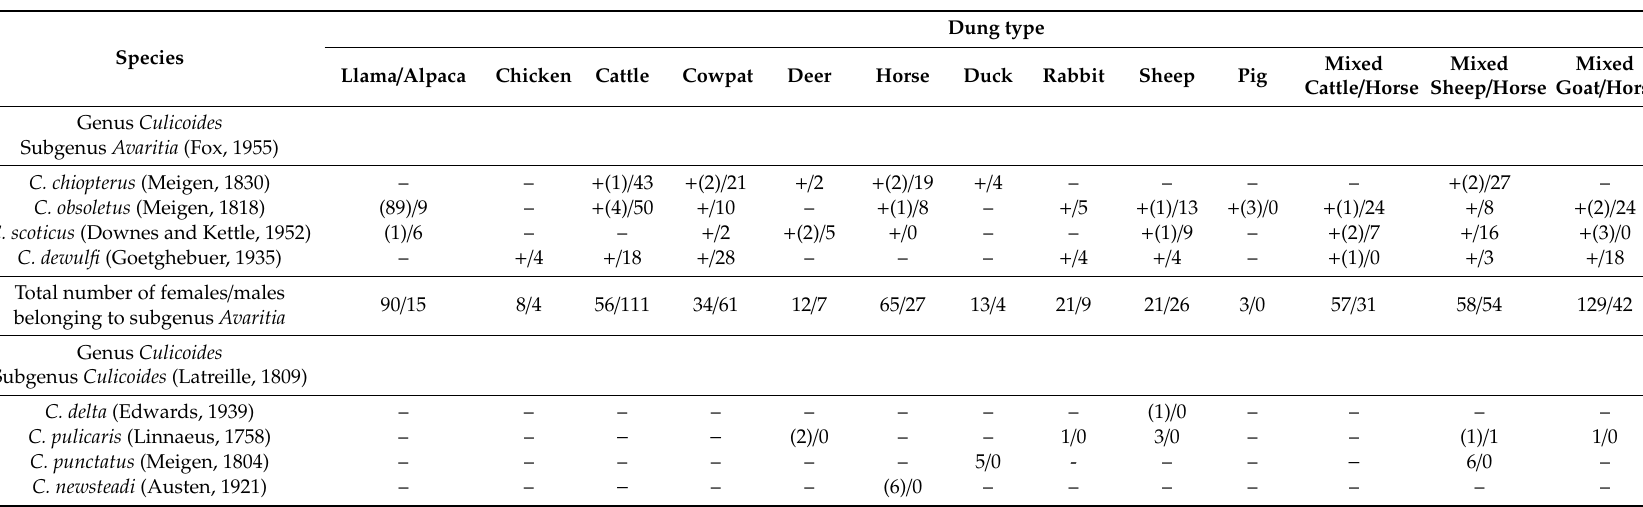
Table 2. Emergence of biting midge subgenera and species from various types of dung (adjusted to a covered ground area of 0.5 x 0.5. m 2 ), based on both qualitative and quantitative data from the years 1994, 1995 and 2007–2012 (females / males; + —present, − —no record; numbers in parentheses represent the number of genetically identified